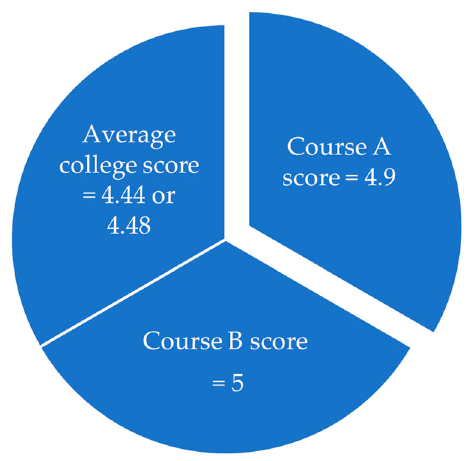
Figure 5. Learning satisfaction score among courses A, B, and college average. Source: Learning satisfaction questionnaires of the researched courses.